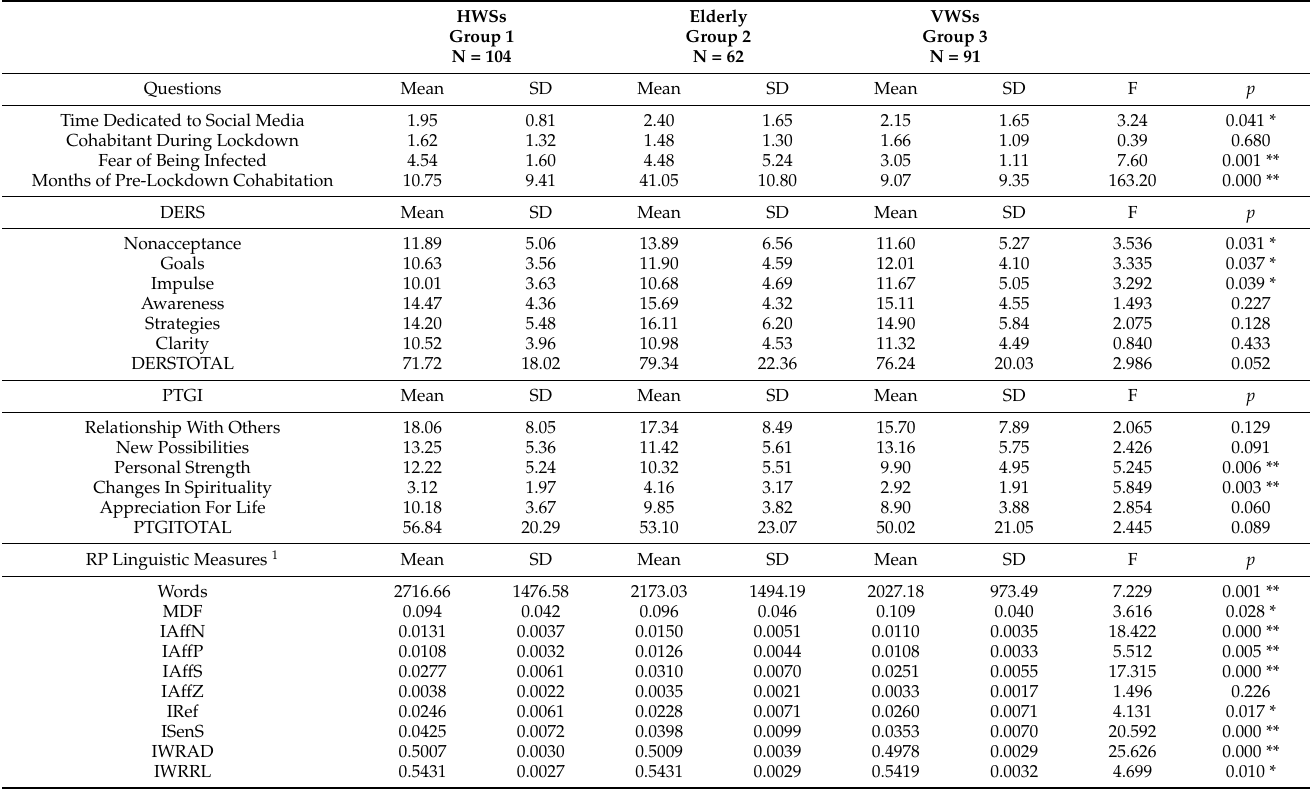
Table 1. ANOVA independent group comparison of HWs, elderly, and